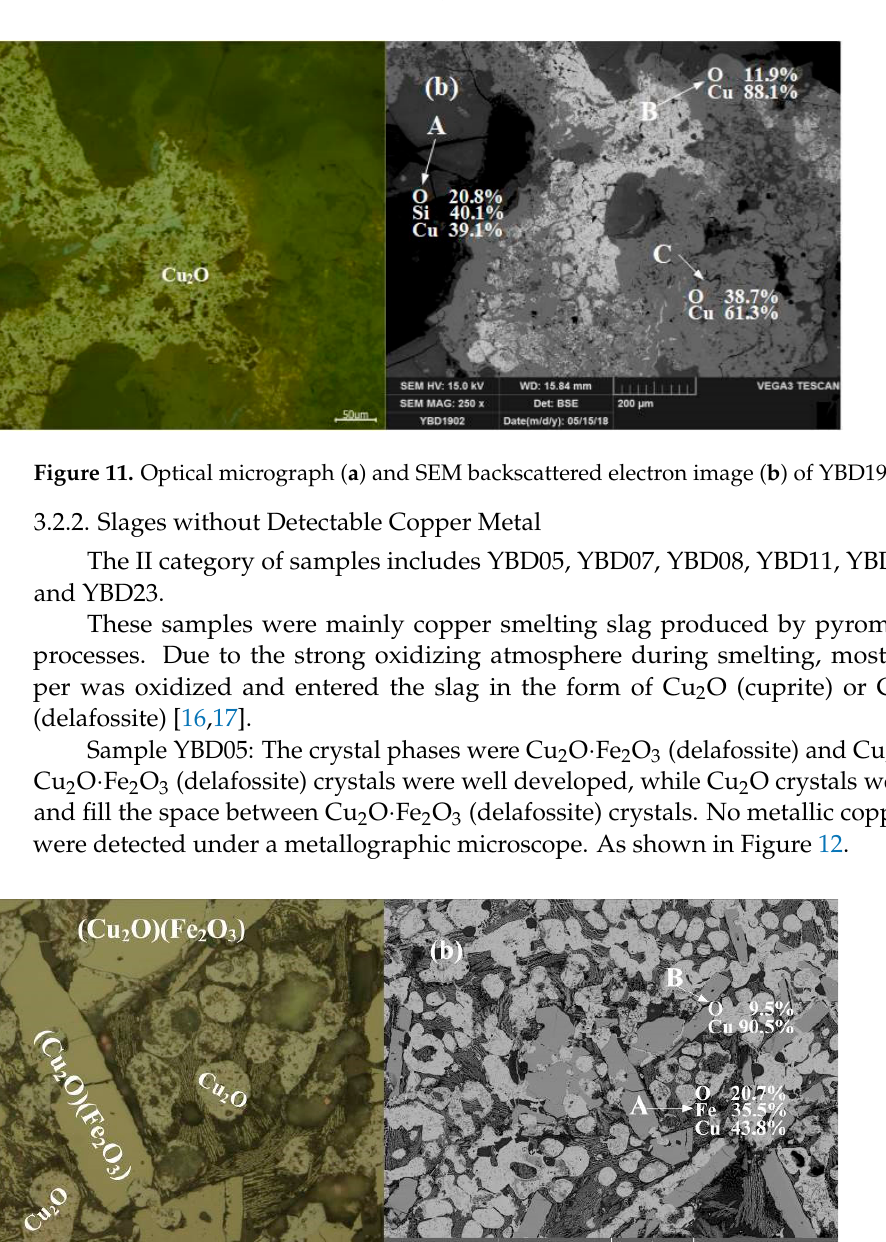
Figure 10. Optical micrograph ( a ) and SEM backsca tt ered electron image ( b ) of YBD13. Sample YBD19: The main component was copper oxide mineral. Among the detected phases, Cu 2 O (cuprite) had the highest copper content and the boundaries between di ff er- ent phases were smooth. As shown in Figure 11.